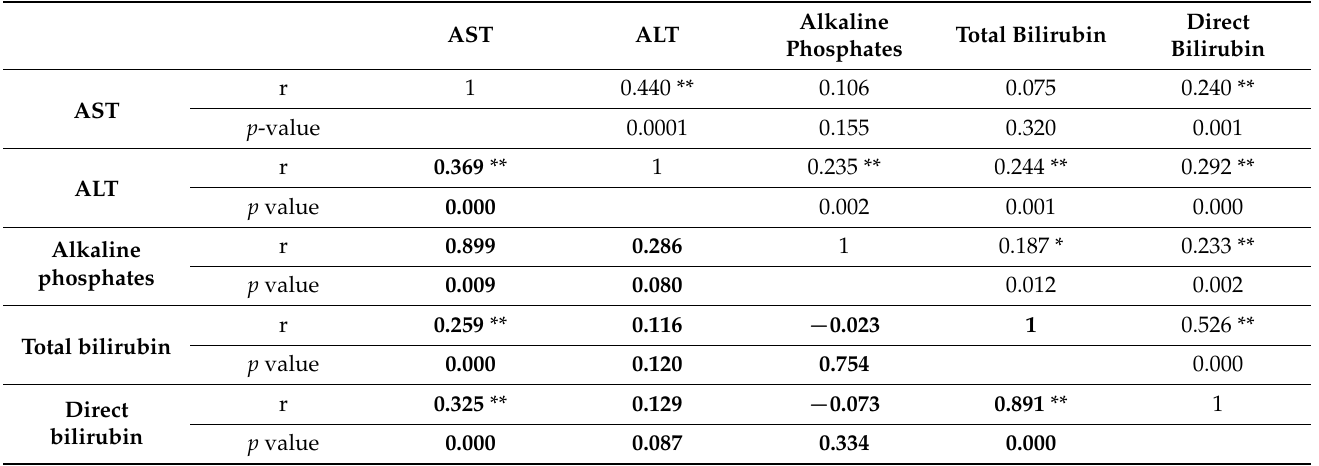
Table 3. Pearson correlation coefficient (r values, p -value) between the liver functions (before: above (normal); after: below (Bold)). AST ALT